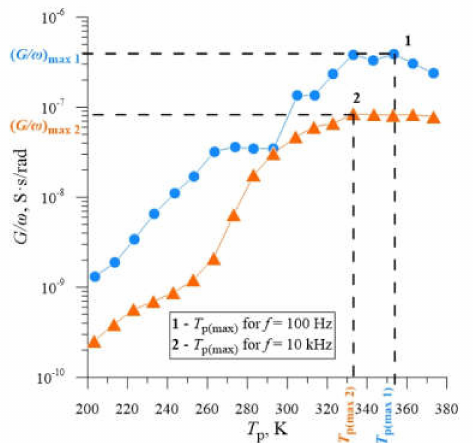
Figure 7. The method of determining the value of G max / ω and T p(max) on the example of the dependence G / ω = f( T p ) for silicon with resistivity ρ = 0.4 Ω cm, doped with boron, implanted with neon ions Ne + with energy E = 100 keV and dose D = 2.2 × 10 14 cm − 2 , plotted for the measurement frequencies f = 100 Hz and 10 kHz and the annealing temperature T a = 598